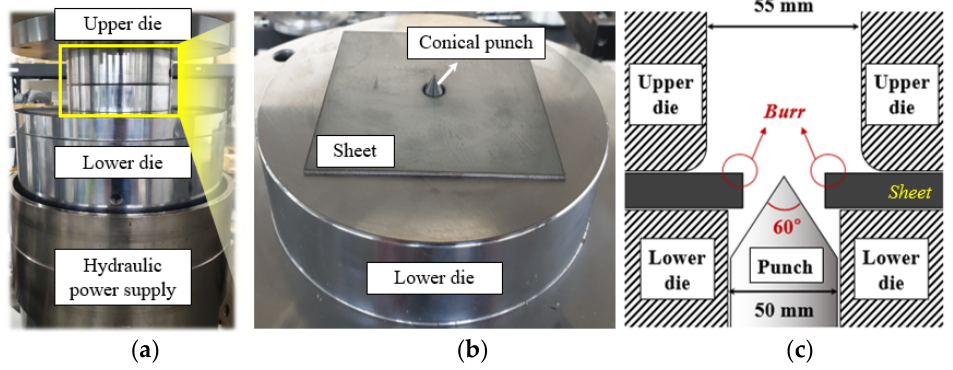
Figure 2 . Schematic diagram of hole expansion test set-up: ( a ) test equipment; ( b ) initial set-up of hole expansion test; ( c ) cross-sectional view of hole expansion test.